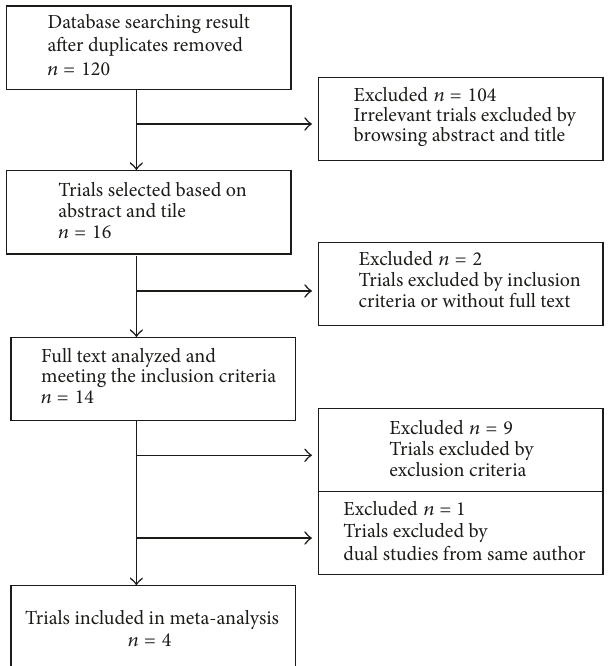
Figure 1: Flow chart showing the selection of studies in the meta-analysis.